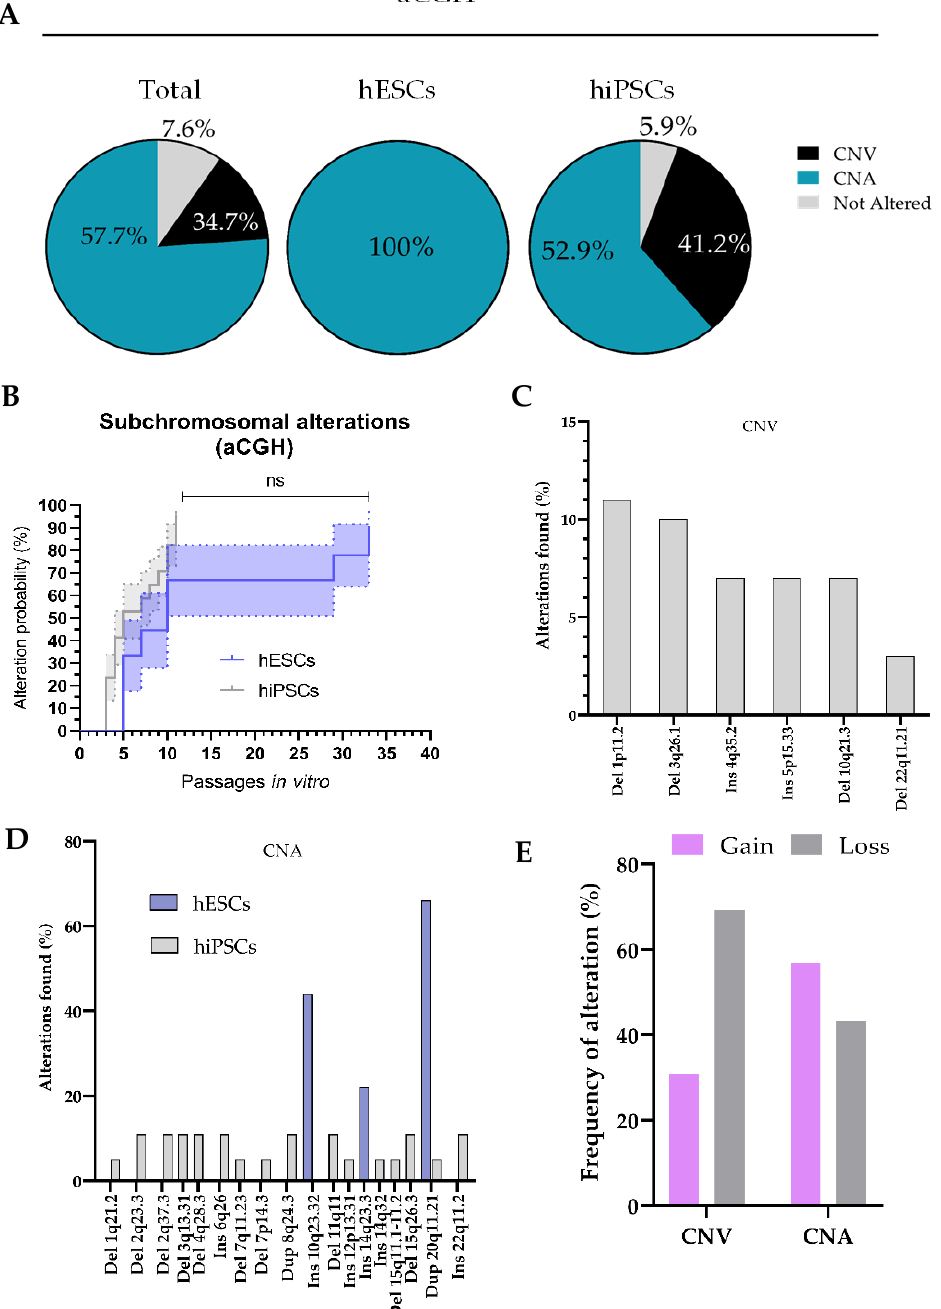
Figure 5. Recurrent subchromosomal Copy Number Variations (CNVs) and pathogenic Copy Num- ber Alterations (CNAs) are detected in cultured hESC s and hiPSCs by Comparative Genomic Hybridization CGH array (aCGH) analysis: ( A ) Pie charts showing the percentage of cells harboring Copy Number Variations (CNVs) or Copy Number Alterations (CNAs), as well as cell lines for which no alteration were detected; ( B ) survival analysis (Kaplan–Meier curves) of the evolution of the probability (%) of hESCs and hiPSCs being affected by subchromosomal genomic alterations detected by aCGH over time (passages in vitro). Error bars represent standard error (S.E.M.); ( C , D ) histograms showing the frequency at which different types of CNVs ( C ) and CNAs ( D ) are found in analyzed hESCs and hiPSCs; ( E ) bar graph showing the frequency at which DNA gains and losses are detected with aCGH for both CNV and CNA group.